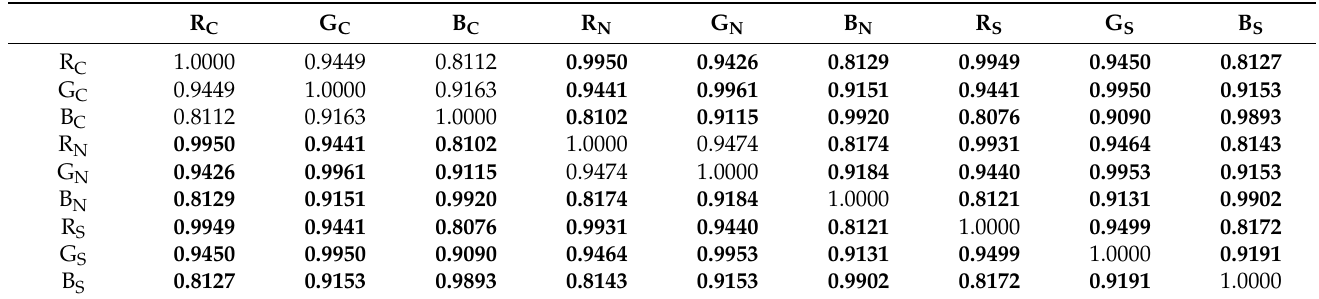
Table 3. Correlation matrix of the new RGB values after the change of gamut. The correlations that increased from those in Table 1 are indicated in bold.